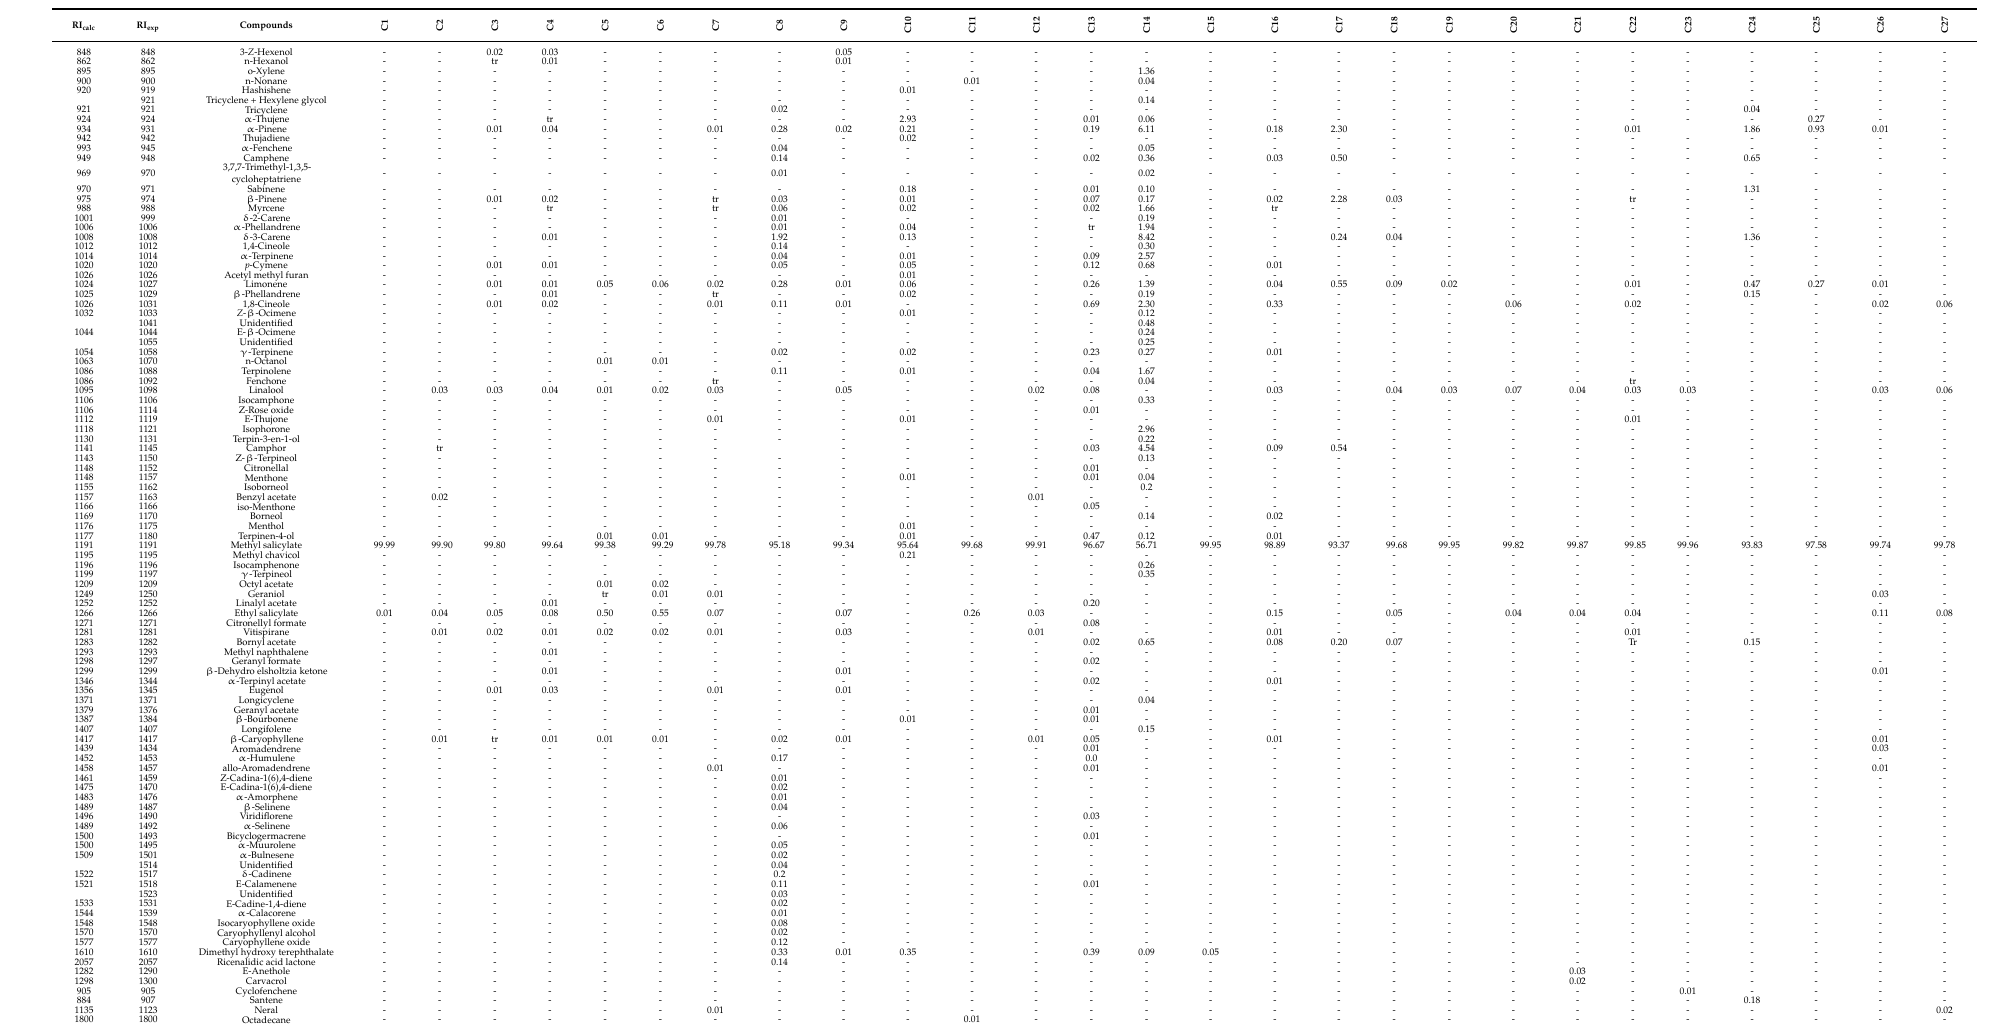
Table 4. Chemical composition of commercial (C) birch EO